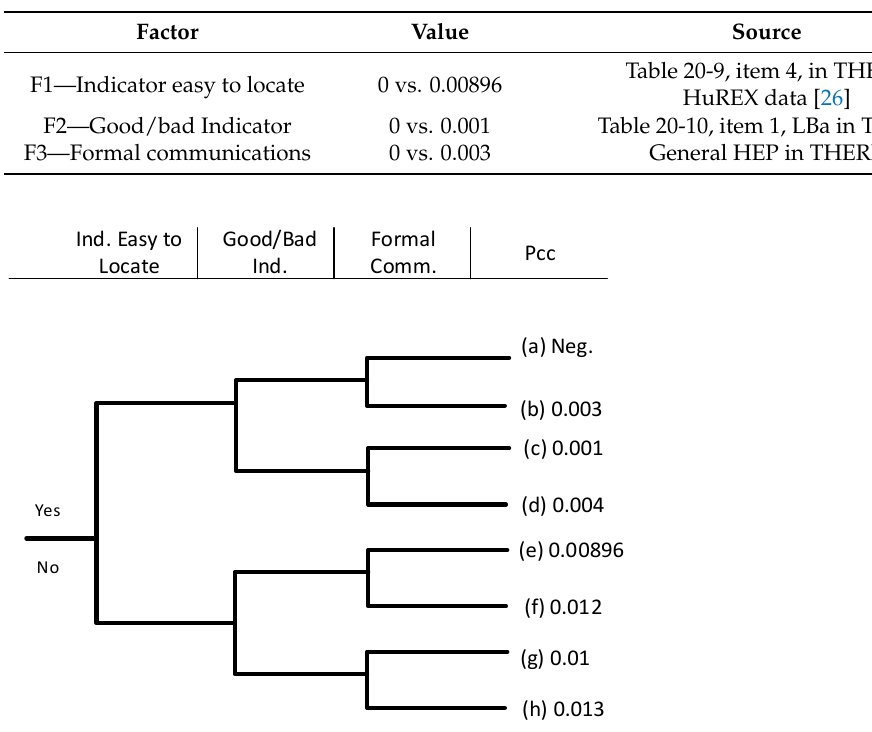
Figure 10. Pcc tree in MCBDT.